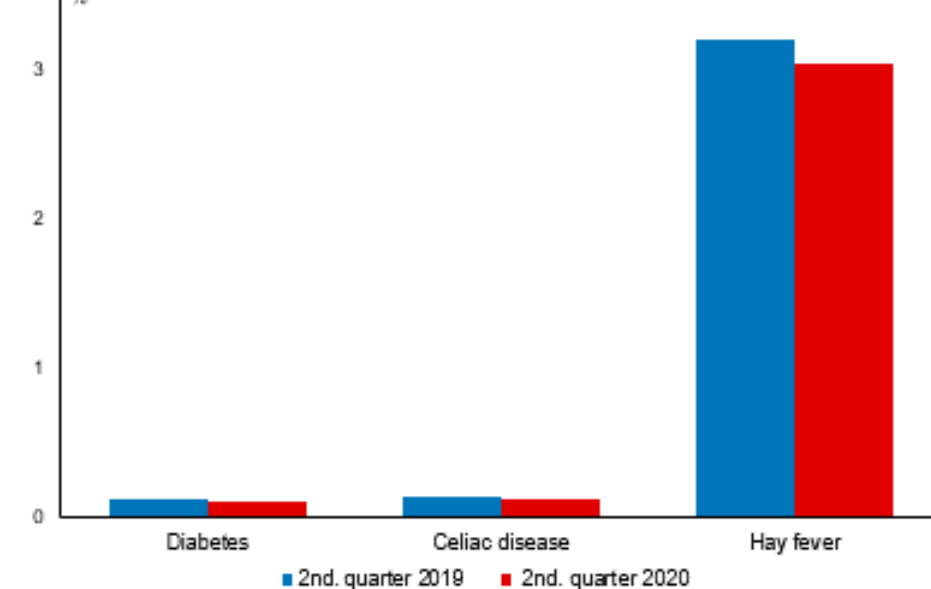
Figure 2. Frequency of diagnosed chronic physical conditions (% of all children) among children aged 1–12 years in the 2nd quarters of 2019 (control) and 2020 (COVID-19 pandemic).